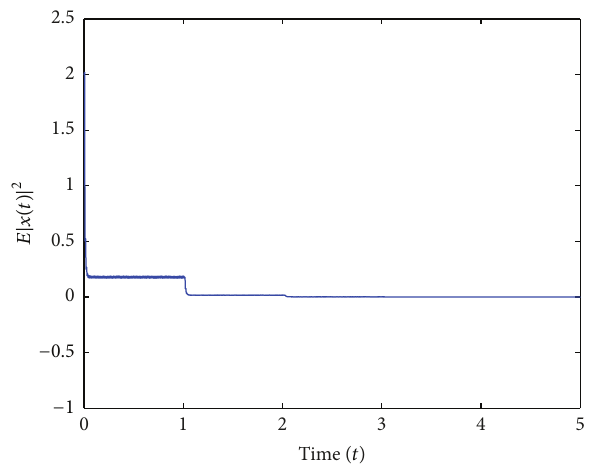
Figure 4: The mean square of the solution of system (47) with impulses (2000